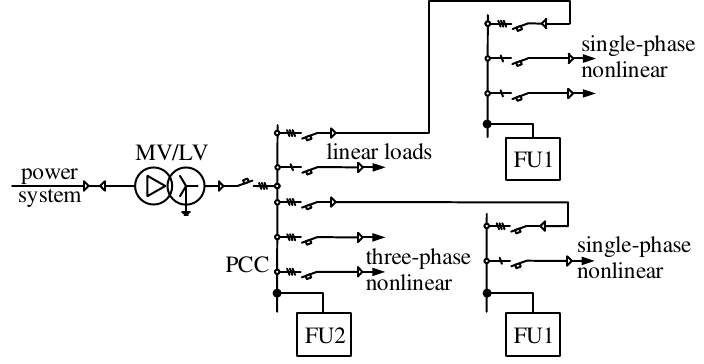
Figure 1. System configuration of distributed power quality conditioning